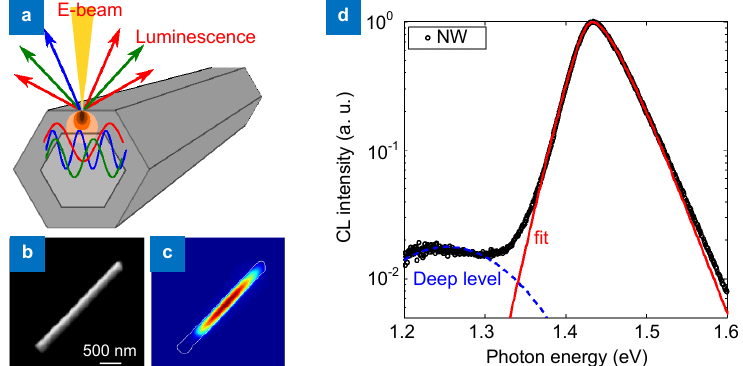
Fig. 5 | ( a ) Schematic of the electron beam interaction with nanowire and luminescence emission. ( b ) SEM image of a single nanowire. ( c ) CL image of a single GaAs nanowire measured at 30 K. ( d ) CL spectrum from nanowire at room temperature and the fit (red curve). Figure reproduced from ref. 54 , ACS Publications.